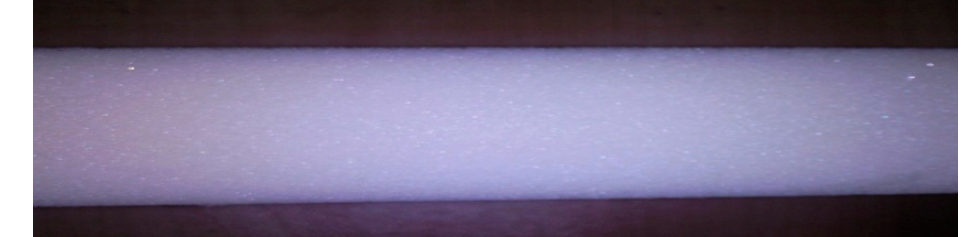
Figure 4. Foam component (Steep cotton): length 1.9 m; density 63.18 (kg/m 3 ); weight 3 kg, thickness 0.02 m.